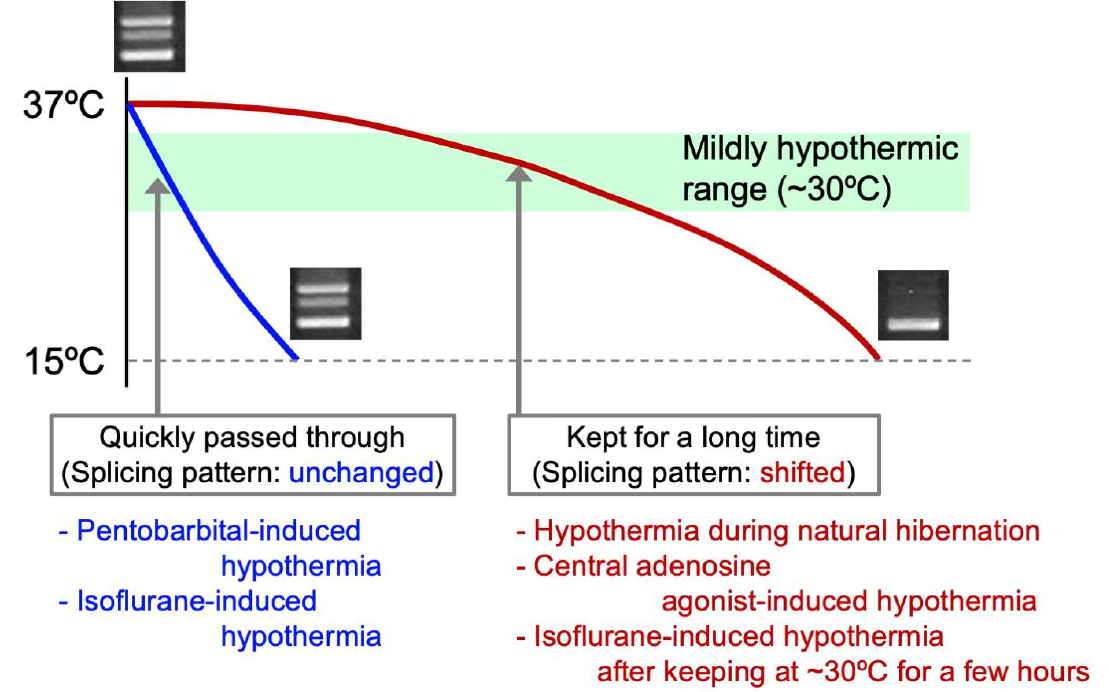
Figure 1. Schema of drop in body temperature contributing to the shift in alternative splicing of CIRP in hamsters. The alternative splicing pattern of CIRP does not change when body temperature quickly passes through the state of mild hypothermia. On the other hand, maintenance of a state of mild hypothermia for a long time can induce the shift in alternative splicing of CIRP as in hibernation.